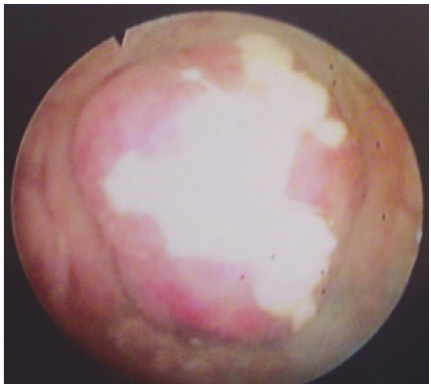
Figure 1: First case tumor cystoscopic appearance.